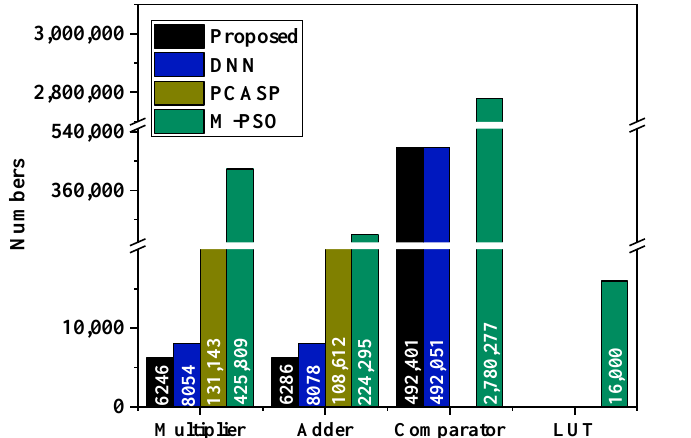
Figure 18. The complexity comparison between the proposed scheme and schemes using DNN, PCASP and